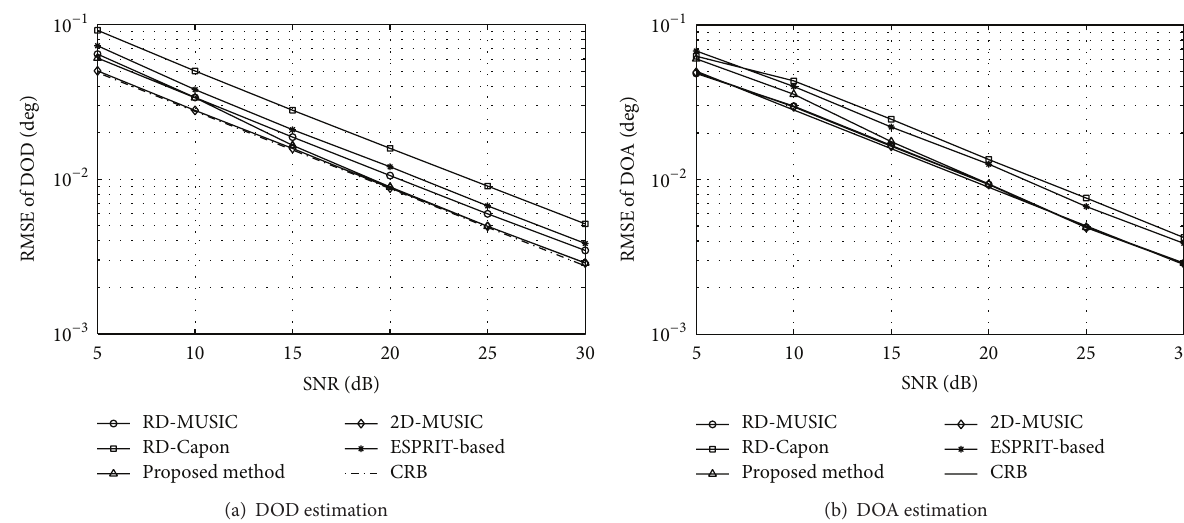
Figure 4: RMSEs of angle estimation against input